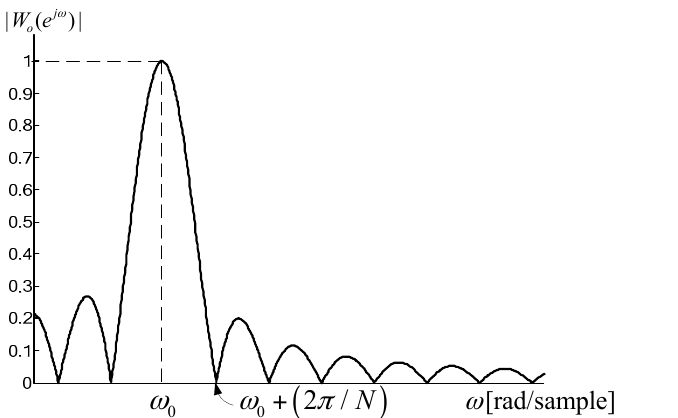
(cid:12) (cid:12) (cid:12) (cid:12) W e ( e j ω ) , (cid:12) W o (cid:12) , for a single-tone o